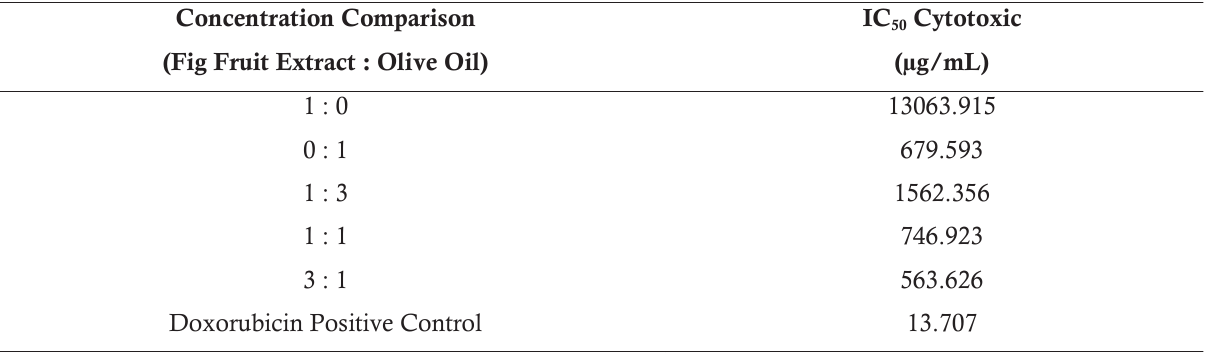
Tabel 3. IC value of figs extract, olive oil and a combination of both by comparison (1:3, 1:1, 3:1) to HeLa 50 cervical cancer cells.